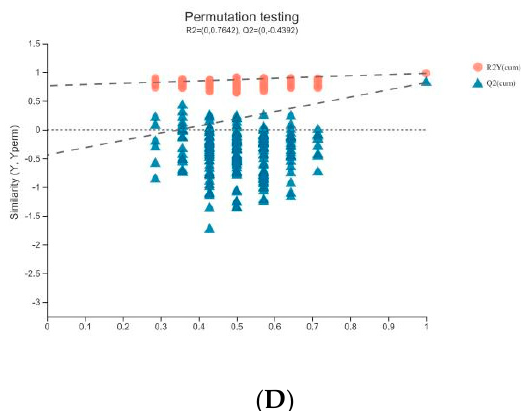
Figure 2. The OPLS-DA model ( A , C ) and permutation test of the OPLS-DA model ( B , D ) were derived from the LC–MS metabolomics profiles of the plasma of Angus cows fed the high-energy diet (HE) and the control diet (CON). ( A – D ) plasma samples analyzed in POS and NEG ion modes; the green and blue colors indicate, respectively, CON and HE diets administered to beef steers ( A , C ). Blue triangles represent the Q2 value, and red dots represent the R2 value from the permutation test ( B , D ). The permutation test results for the Q2 intercepts were − 0.37 for serum POS and − 0.43 for plasma NEG; the results are presented in Figure 2B,D. Both positive and negative data revealed a clear separation of the CON and HE groups. The significantly different metabolites were visualized through volcano plots (Figure 3), which clearly showed many different metabolites distinguishing the two groups. As displayed in Table 3, among the 51 significantly different metabolites in the plasma, 22 metabolites had higher concentrations in the CON-fed cows than in the HE-fed cows (Table 3). Additionally, the concentrations of most identified fatty acids decreased in the